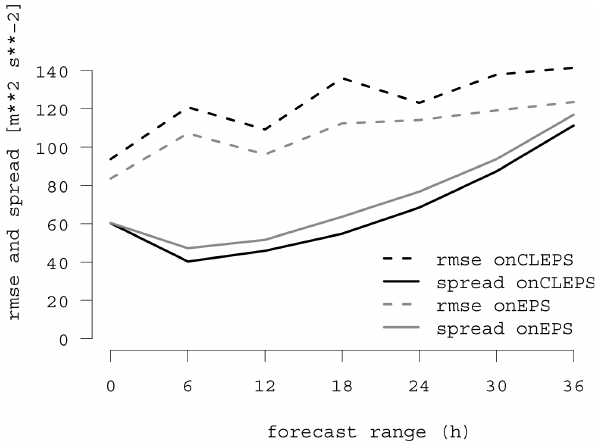
Fig. 2. RMSE of the ensemble mean (dashed lines) and ensem- ble spread (solid lines) for COSMO-H2-EPS (black, labelled “on- CLEPS”) and EXP-H2-EPS (grey, labelled “onEPS”), in terms of geopotential at